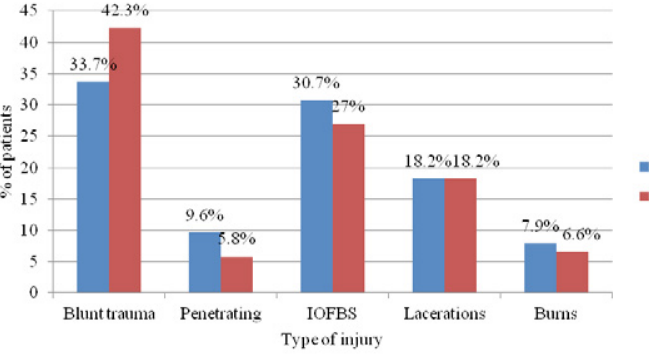
Figure 2 . Types of injuries in relation to gender of the patients